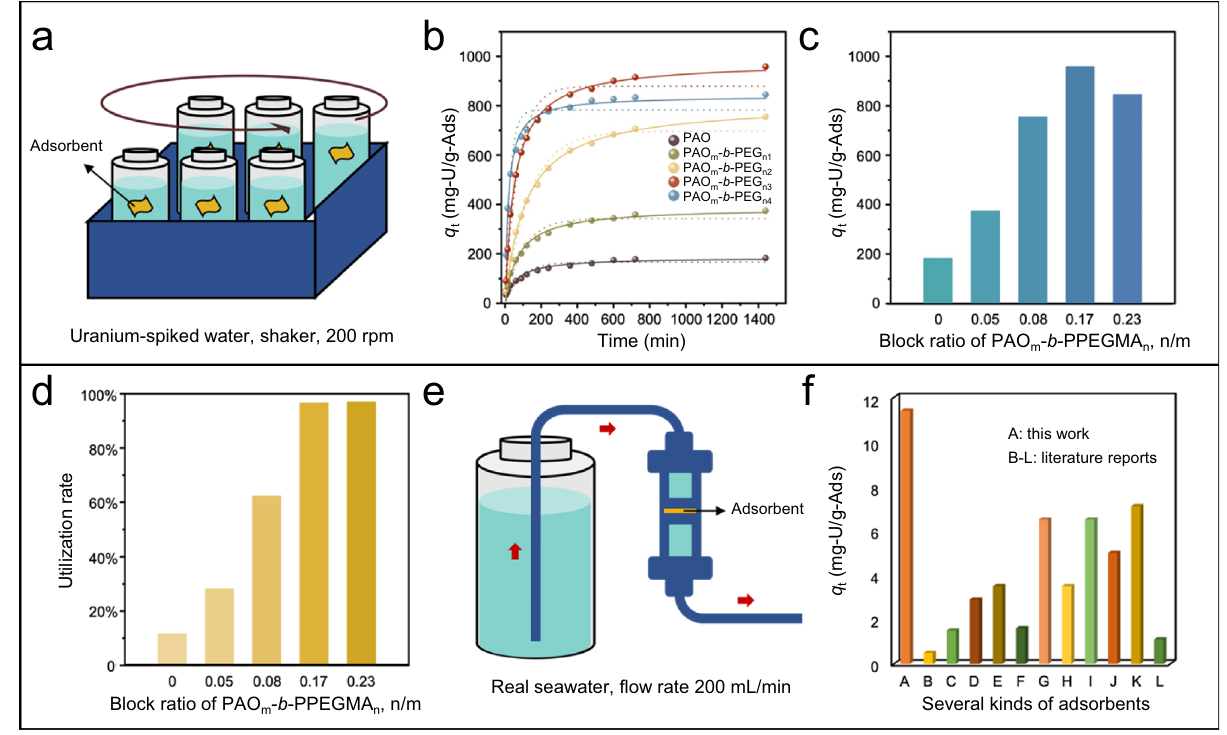
Fig. 8 Adsorption experiments in spiked uranium solution and real seawater. a Illustration of batch adsorption in U-spiked solution on a shaker operating at 200 rpm. b Adsorption capacity of the electrospun BCPs in U-spiked solution varying with contact time. c Equilibrium adsorption capacity of the electrospun BCPs with different block ratios. d Utilization rate of the AO ligands in the electrospun BCPs with different block ratios. e Illustration of real seawater adsorption test in a continuous- fl ow system. f Comparison of the adsorption capacity in real seawater for different AO-functionalized polymeric adsorbents, including the electrospun PAO m - b -PPEGMA n3 in this work (A), PE/PP- g -(PAO- co -PMA) 57 (B), PP- g -(PAO- co -PMA) 58 (C), PE- g -(PAO- co - PVPA) 21 (D), PE- g -(PAO- co -PITA) 20 (E), PAO/PVDF 59 (F), PAO (PIDO NF) 37 (G), PE/PP- g -PHEA-(PAA- co -PAO) 27 (H), SMON-PAO 60 (I), UHMWPE- g - PHEA-(PAO- co -PAA) 35 (J), PAO-Alg NFs 61 (K), and PAO-G-A 36